Question: In one sentence, what is this figure communicating?
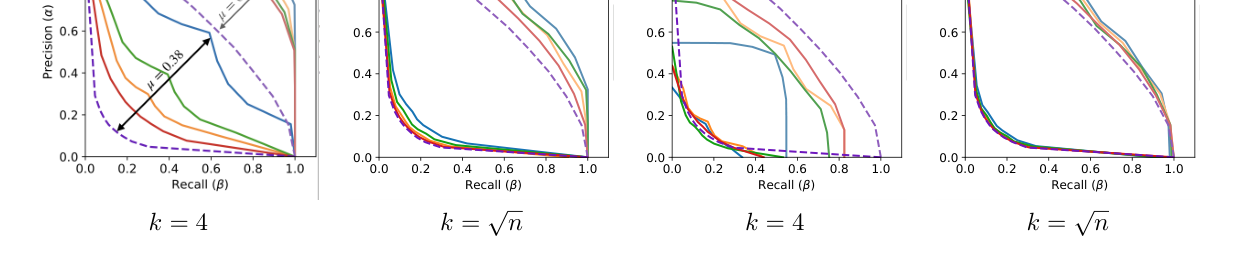
Answer: Comparing two shifted Gaussians. The Ground-Truth PR curve ( - -GT) is compared to empirical estimates from various NN-classifiers: –IPR, –KNN, –PARZEN, and –COVERAGE. Here P ∼N(0, Id) and Q ∼N(µ1d, Id) with d = 64 dimensions and µ = 1 √